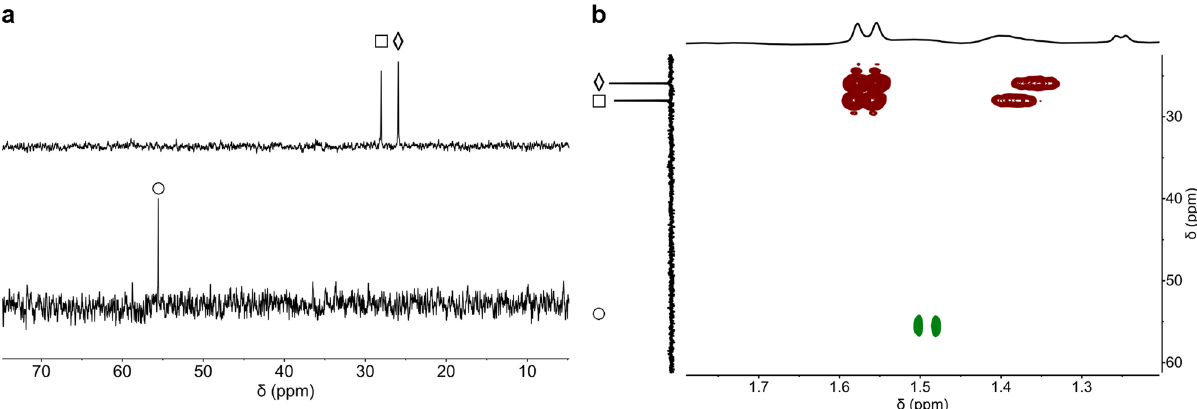
Fig. 6 KDM4E JmjC catalyses demethylation of H3K P 9me 3 to give H3K P 9me 2 H and H3K P 9me 2 O as monitored by 31 P NMR and 1 H- 31 P HMBC. a 31 P NMR analyses of H3K P 9me 3 ( ◊ ) incubated with KDM4E, addition of acid (top) or quenched by heating (bottom). Evidence for formation of H3K P 9me 2 H ( □ , δ = 28.4 ppm, top) and H3K ○ , δ = 55.6 ppm, bottom). b Overlay of 1 H- 31 P HMBC analyses of the solutions after of H3K P P 9me 2 O ( P KDM4E JmjC , quenched by heating (green cross peaks), or addition of acid (red cross peaks). Experimental conditions: H3K P 9me 3 (500 µ M), Asc (1.00 mM), 2OG (1.00 mM), Fe(II) (100 µ M), KDM4E JmjC (50